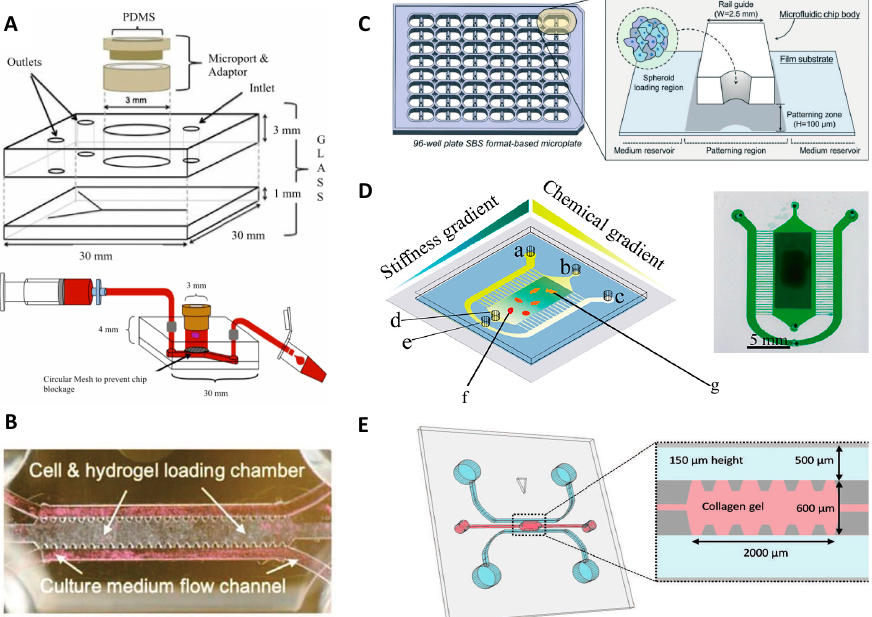
Figure 3. Reconstituting glioma microenvironment and studying cell behaviors via on-chip platforms. ( A ) Representative images of the microfluidic culture system setup [37]. Reproduced with permission from [37]. ( B ) GBM-microvasculature-on-a-chip model. The microfluidic system contained three channels; one for cell embedded hydrogels and the other two channels for culture medium flow [38]. Reproduced with permission from [38]. ( C ) Sphero-IMPACT 96-well microfluidic system. The area for cell culture was located between the medium reservoirs [39]. Reproduced with permission from [39]. ( D ) Conceptual image of microfluidic chip platform allowing stiffness and chemical gradients simultaneously. a, b and c illustrate inlets; d and e show outlets of cell culture and solutions, respectively; f and g represent culture area that includes U87 cells loaded with EGF [40]. Reproduced with permission from [40]. ( E ) Microfluidic chip for cell invasion study. Cells were seeded into the two parallel channels demonstrated with blue, and pink area that represents the area containing type I collagen [41]. Reproduced with permission from [41].